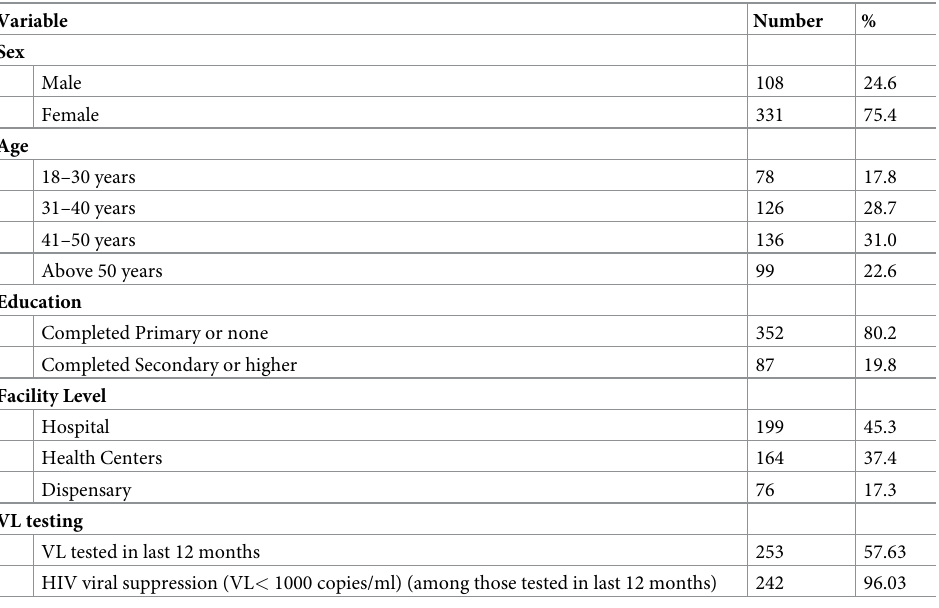
Table 1. Patients demographics and clinical characteristics, N =